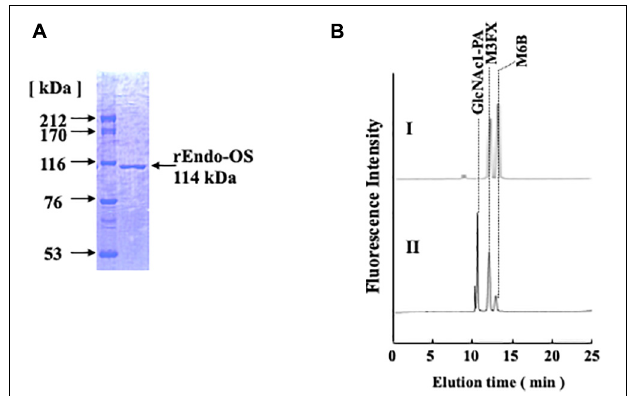
FIGURE 6 | Effects of metal ions, detergent, and chaotropic ions on Endo-Os activity. Enzymes were incubated in 0.5 M MES buffer at pH 6.0, containing metal ions (6 mM), detergent (2 and 4 M), or chaotropic ions (0.1 and 0.5%) at 37 ◦ C for 30 min. Enzyme activity was determined using M6B as a substrate and M3FX as an internal standard.